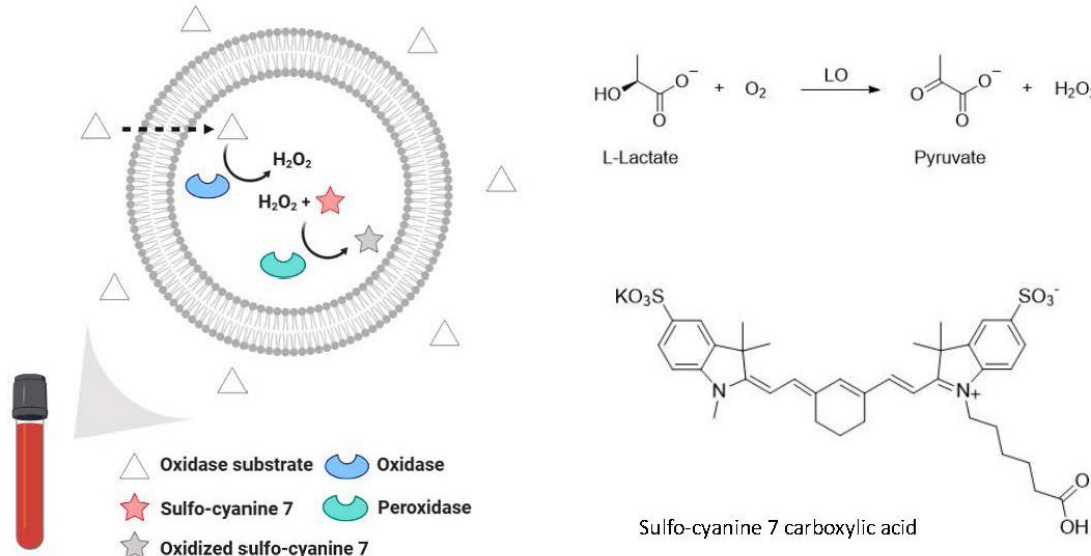
Figure 35. Application of enzyme-containing lipid vesicles for the quantification of L-lactate in whole blood samples, as developed by Matoori and Mooney (2020) [486]. Schematic representation of the principle of the method (not drawn to scale). Lipid vesicles of about 7–8 µ m diameter, formed from DPPC, cholesterol, and DSPE-PEG2000, containing entrapped L-lactate oxidase from Aerococcus viridans (LO, “oxidase”), HRP (“peroxidase”), and fluorescent sulfo-cyanine 7 carboxylic acid (“sulfo-cyanine 7”) were prepared at pH = 7.4. L-lactate (“oxidase substrate”) present in blood samples added to the vesicles ( pH = 6.1) permeate across the vesicle bilayer(s) (indicated by the dashed line). Inside the vesicles L-lactate is oxidized to pyruvate and H 2 O 2 (catalyzed by LO), followed by a HRP-catalyzed oxidation of sulfo-cyanine 7 carboxylic acid to “oxidized sulfo-cyanine 7”, which can be monitored by a decrease in fluorescence intensity; see text and [486] for details. Drawing reproduced with permission from [486], WILEY-VCH Verlag GmbH & Co. KGaA, 2020.